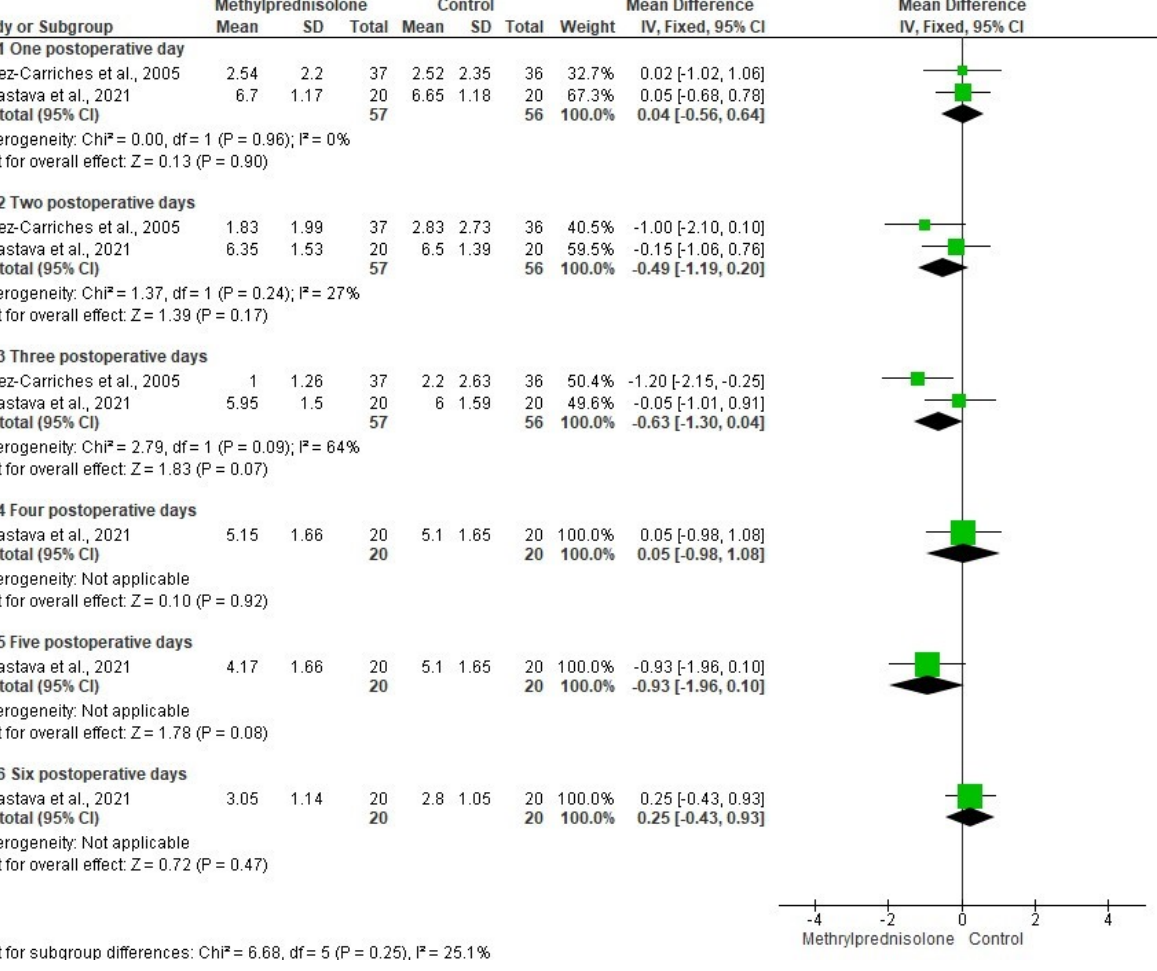
Figure 3. Meta ‐ analysis of the pain intensity using the VAS [25,30]. Figure 3. Meta-analysis of the pain intensity using the VAS